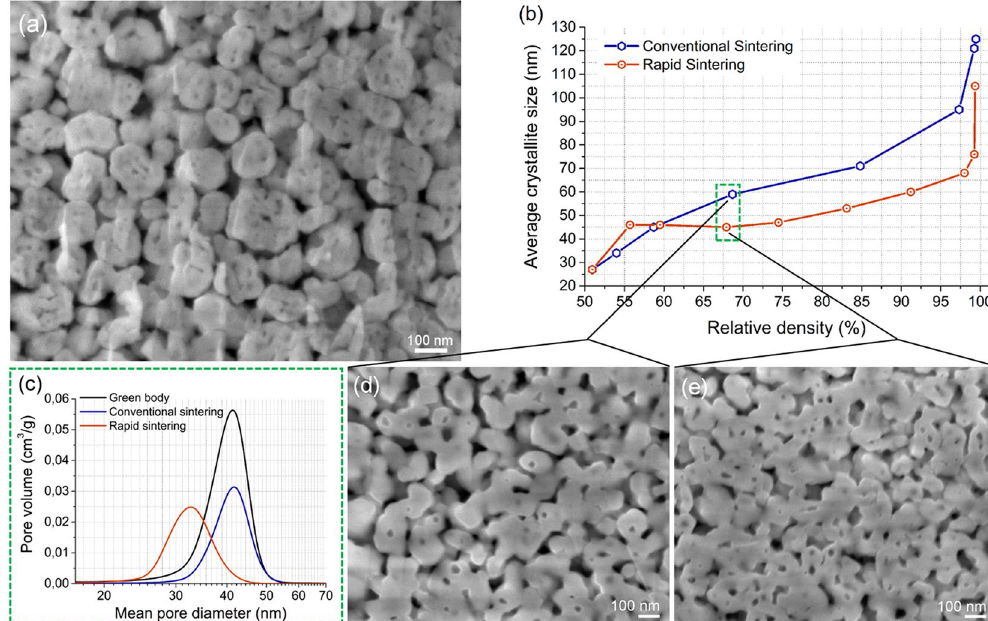
Figure 1. Observation of densification via crystallite growth and/or crystallite coalescence and rearrangement during conventional (CS) and rapid (RS) sintering. ( a ) 3YSZ green body with hierarchical heterogeneities originating from the dense and homogeneous packing of the loosely agglomerated nanocrystals forming secondary particles. ( b ) Crystallite size-density trajectories comparing the CS and RS of the 3YSZ green body derived from the Rietveld refined X-ray diffractograms. ( c ) Incremental pore size evolution during the RS and CS as determined by mercury porosimetry taken at the sintering conditions and relative densities from the green-dotted box in b and compared to the green body in a. ( d,e ) SEM images of the CS and RS samples sintered at 5 °C/min to 1100 °C for 2 h and 250 °C/min to 1200 °C for 2 min, respectively, to yield similar relative densities for comparison